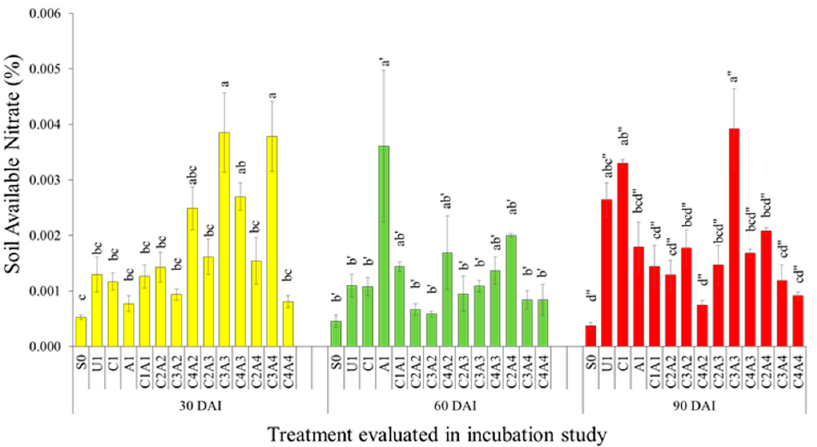
Figure 14. Treatments on soil available nitrate ions after thirty, sixty, and ninety days of incubation. Means with different letter(s) within the same incubation period indicate significant difference between treatments by Tukey’s HSD test at p ≤ 0.05. Bars represent the mean values ±